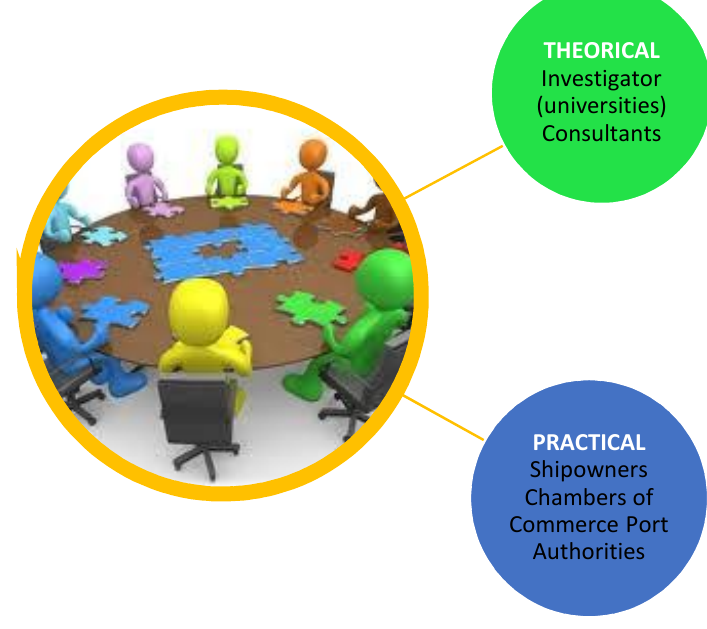
Figure 3. Expert Panel Classification.